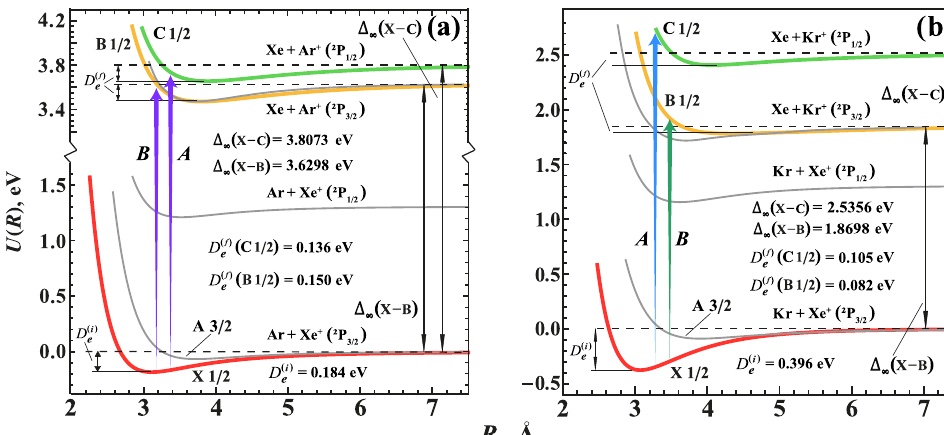
Figure 2. ( a ) Electronic terms of first six electronic states of ArXe + ion calculated in [24,49]. Values A and B denote the strongest dipole-allowed transitions. ( b ) The same for KrXe + . ∆ ∞ ( X − B ) and ∆ ∞ ( X − C ) are the energy separations between the ground state, X 1/2, and excited states with charge transfer characters, B 1/2 and C 1/2, at the dissociation limit ( R → ∞